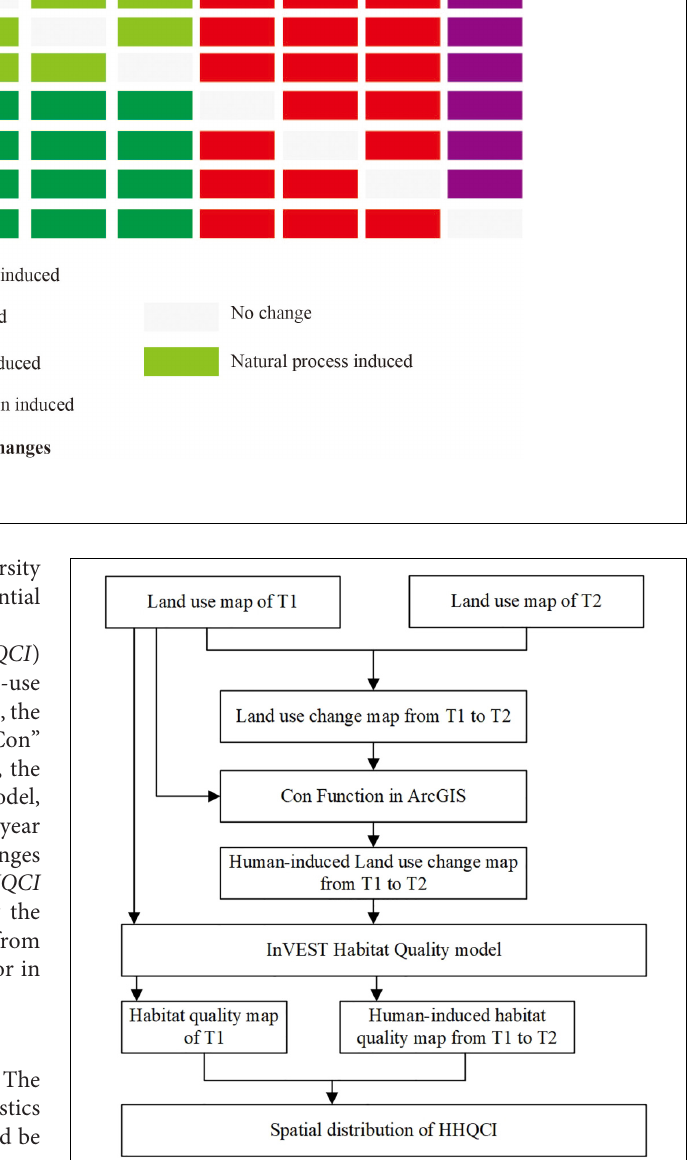
FIGURE 3 | Flowchart of HHQCI